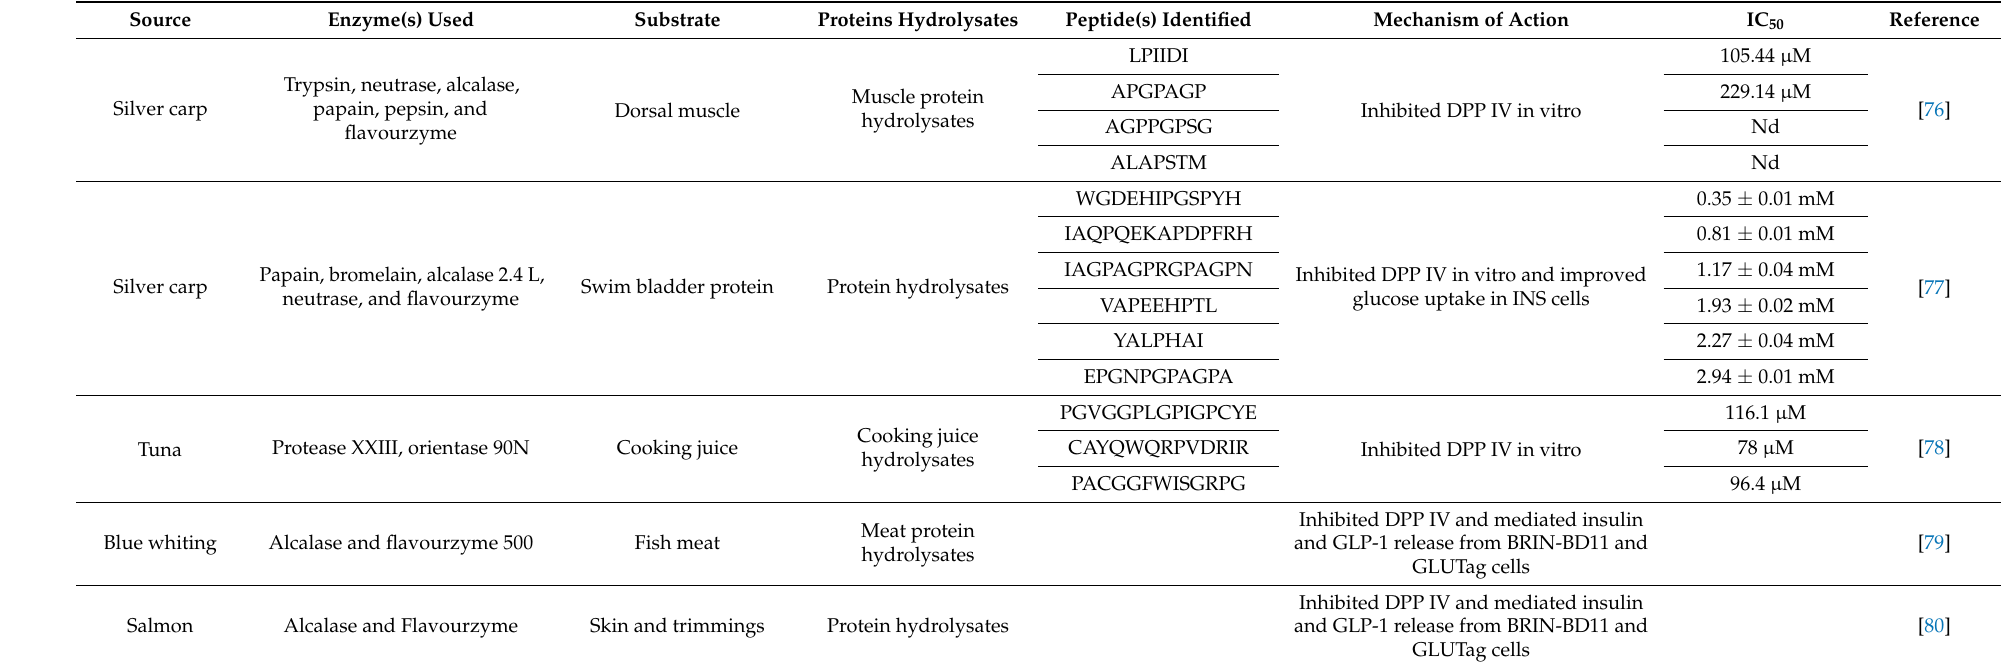
Table 2. Antidiabetic action of peptides and protein hydrolysates identified from